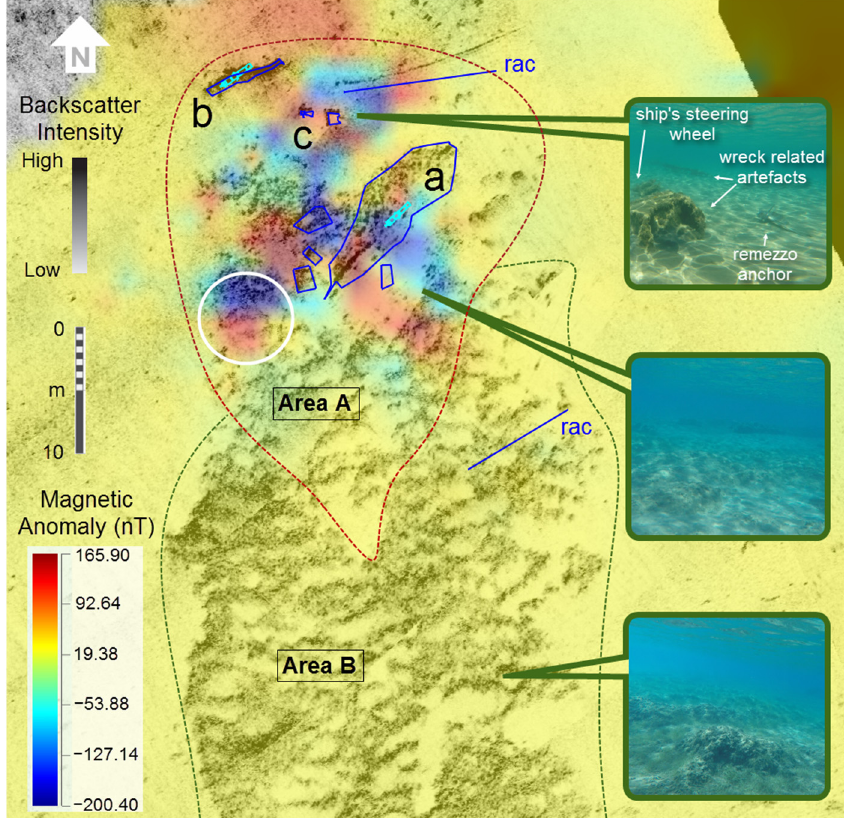
Figure 6. Magnetic anomaly map overlaid on backscatter imagery of ‘wreck site 1’. Polygon drawings (in blue colour) display the wreck mound periphery and scattered wreck-related ruins, while linear drawings refer to remezzo anchor chains (rac). Light blue drawings correspond to cannons found over the wreck mound ( a ) and a gunwale-like feature ( b ). ( Area A ) includes the wreck mound, scattered archaeological material ( c ) and buried ferromagnetic material under sediment heaps (e.g., in a white circle). ( Area B ) is characterised by accumulated sediments in seagrass meadows without detection of magnetic anomalies.